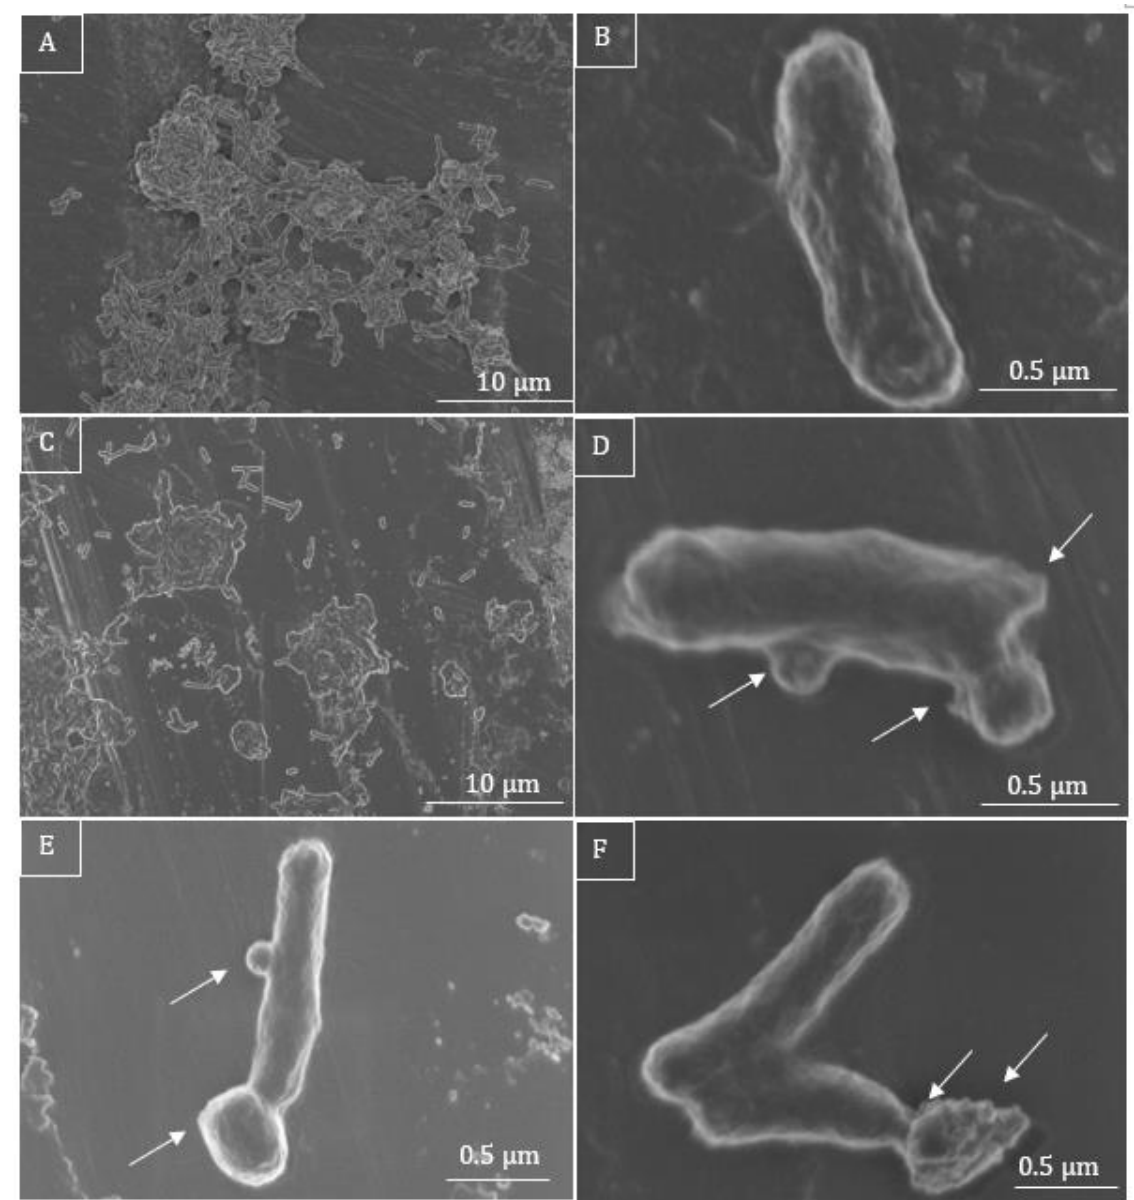
Figure 7. SEM micrographs of E. coli . Untreated bacteria are long, intact, and evenly shaped ( A , B ), whereas C7-treated bacteria are rather clustered ( C ) and present irregular shapes and surface corrugated ( D – F ). When incubated with a sub-MIC of 2 µ g/mL ( D – F ), the cells show blisters on their surface, close to the polar and septal regions, as well as small protruding bubbles on their surface ( D – F , white